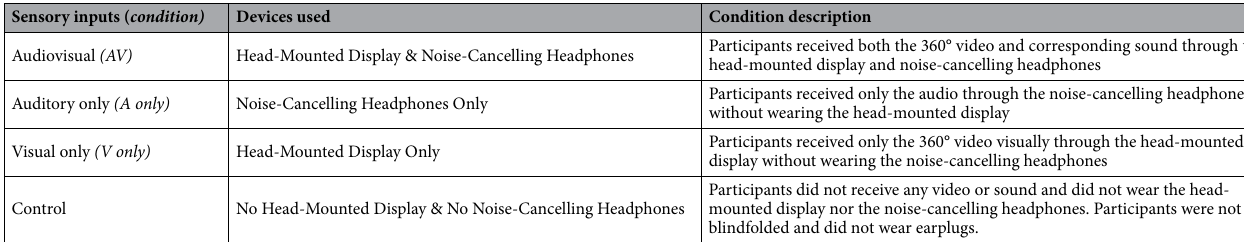
Table 1. Descriptions of the four different test conditions.